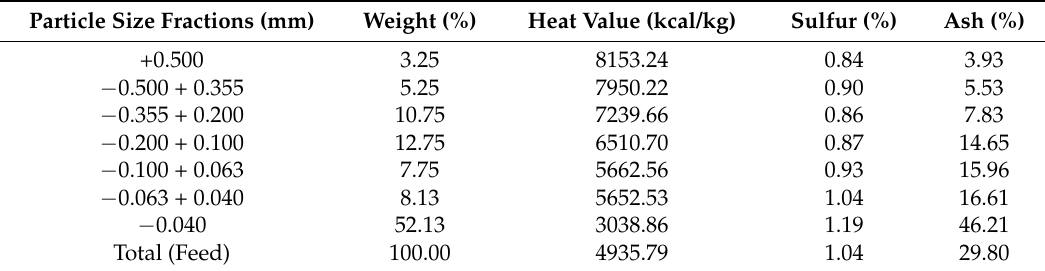
Figure 1. A simplified flowsheet of the Prosper-Haniel Coal Preparation Plant. Table 1. Properties of the hard coal slime sample according to particle size fractions.